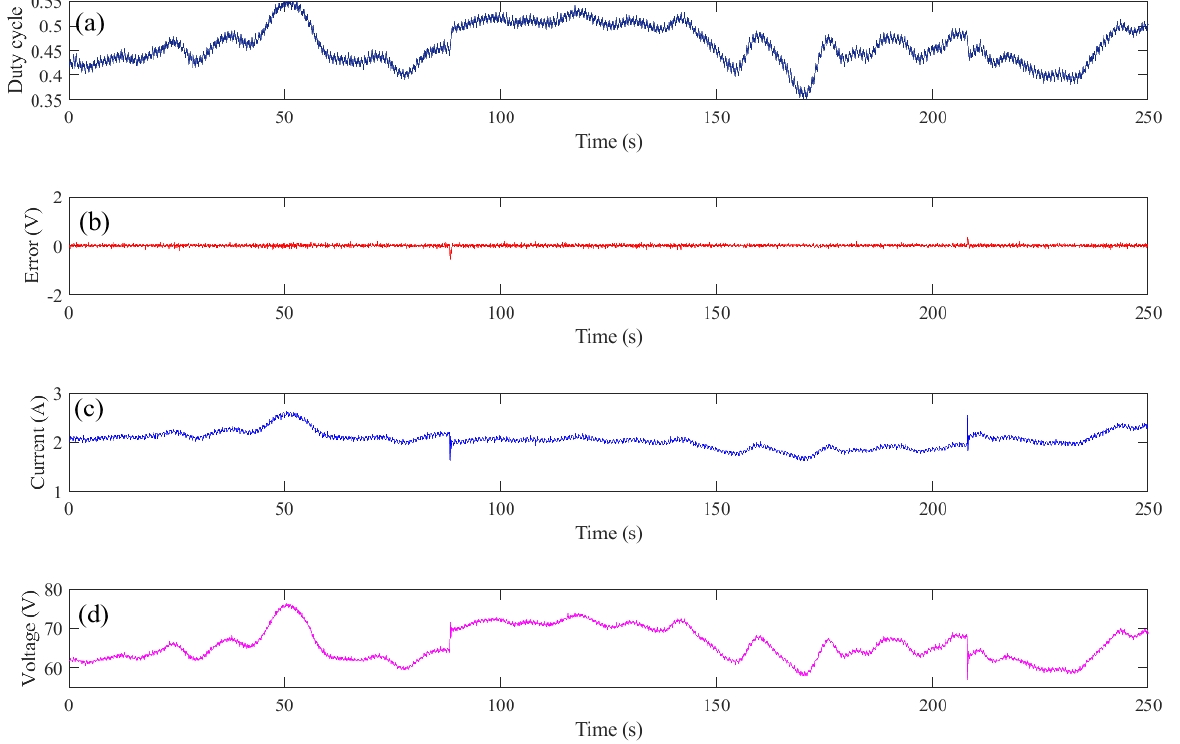
Figure 24. MPPT based on RNN and MPC: ( a ) Duty cycle; ( b ) Error; ( c ) Boost converter output current ( I out ); ( d ) Boost converter output voltage ( V out